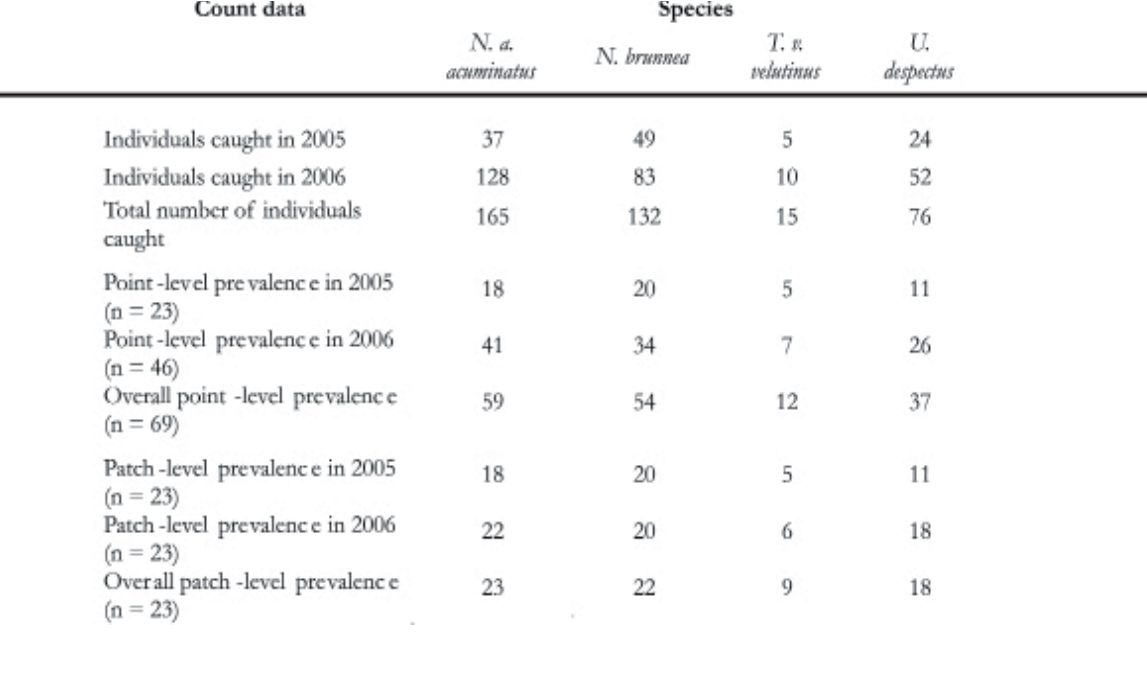
Table 3. Catch data for study species. Point-level prevalence refers to the number of trap arrays at which the species was caught. Patch-level prevalence refers to the number of forest patches within which the species was